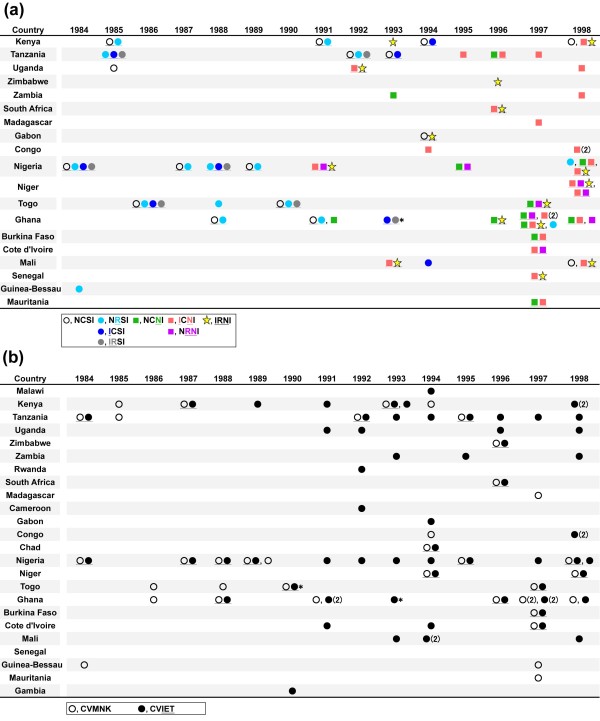
Time-line scheme for dhfr and pfcrt genotypes determined using samples from Africa between 1984 and 1998. (a) Wild-type (NCSI), pyrimethamine-sensitive (NRSI, ICSI, IRSI) and pyrimethamine-resistant (NCNI, ICNI, NRNI, IRNI) dhfr genotypes of Plasmodium falciparum are shown by the different coloured symbols, as listed at the bottom of the figure. In samples with mixed genotype infections, the different genotypes are listed together and underlined. Values in parentheses are the number of samples. *One individual that returned from Ghana in 1993 also visited Burkina Faso in the same trip. (b) Wild-type (CVMNK) and chloroquine-resistant (CVIET) pfcrt genotypes of P. falciparum are shown by white and black circles, respectively. In samples with mixed genotype infections, the different genotypes are listed together and underlined. Values in parentheses are the number of samples. *One individual returning from Ghana in 1993 and one individual returning from Togo in 1990 also visited Burkina Faso in the same trip.